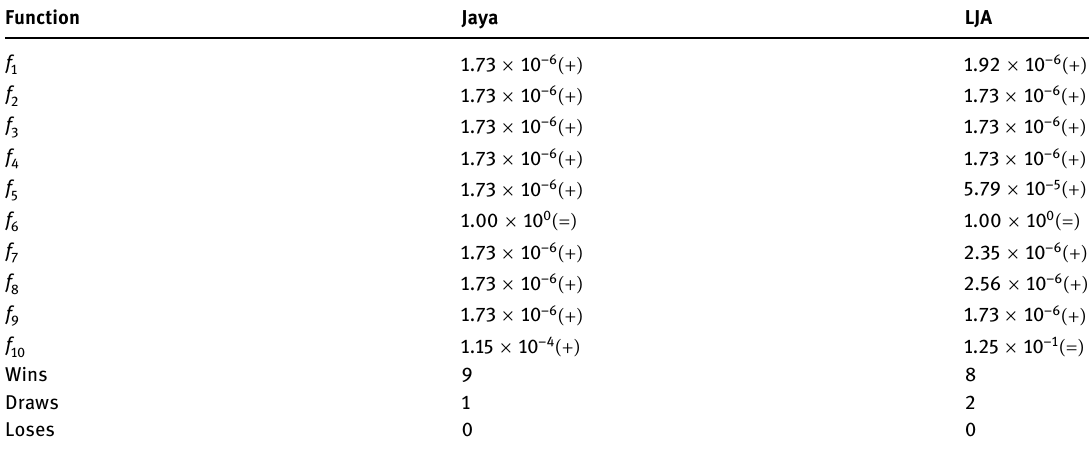
Table A2: The CEC 2020 ( = D 20 ) statistical analysis showing the Wilcoxon test p - value Function Jaya